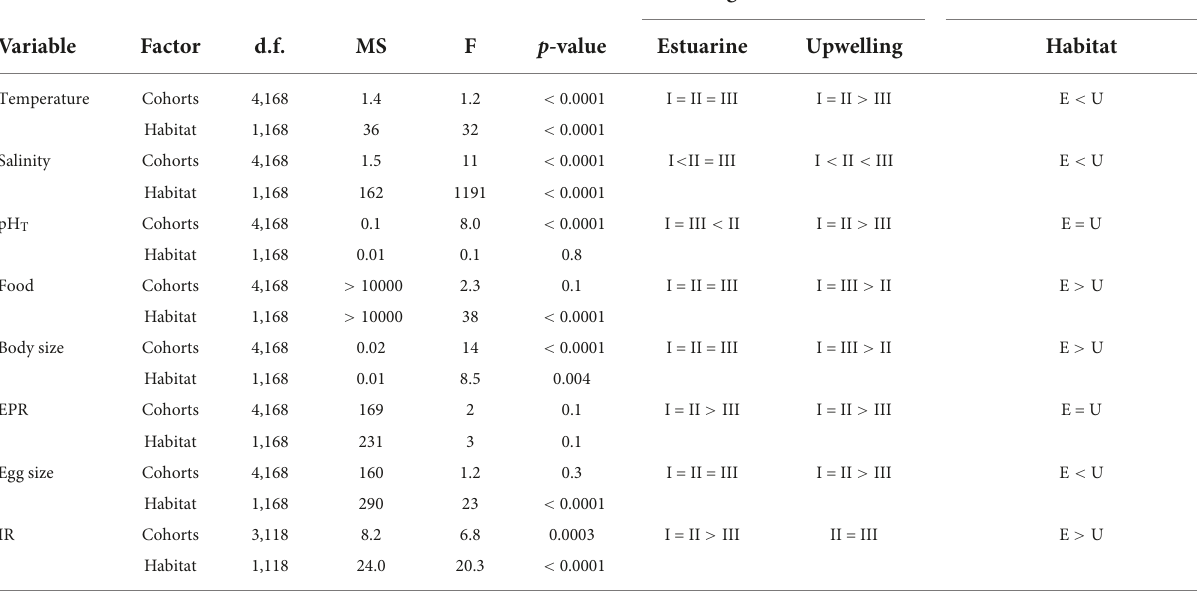
TABLE 2 Comparison of environmental drivers and copepod traits regarding two variability factors: cohorts (3 levels) and habitats (2 levels). Among cohorts Post hoc Between habitats Post hoc